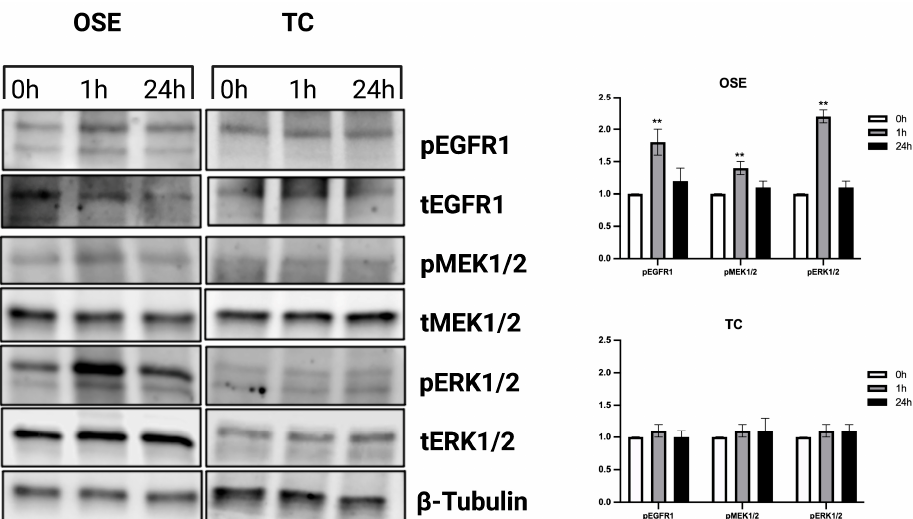
Figure 8. Time course of EGF signaling cascade in FEO cultured in the presence or absence of OSE and TC. Immuno-blot analysis of EGF signaling cascade phospho-activation in FEO with OSE and TC was performed at 0, 1, and 24 h. Three independent biological replicates were performed, and a representative blot is shown. Eight follicular walls per group were processed and collected at 0, 1, and 24 h of FEO. Protein quantification graphs report media of signals detected in the three tested biological replicates. The significance of protein expression values ( p < 0.05) was statistically analyzed vs. 0 h of FEO and indicated with (**) for p < 0.01.